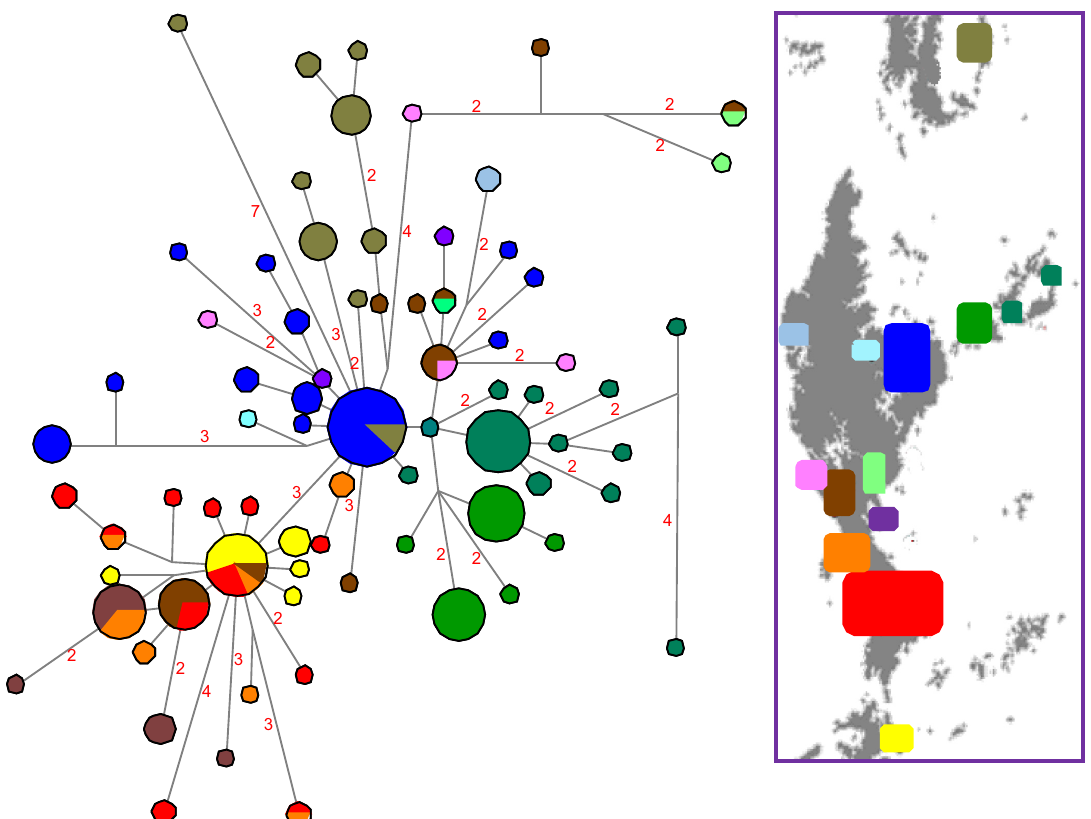
Fig 3. Median joining haplotype network of B . saxicola Southern clade. Legends for the colors of locations are indicated in the map. The number of substitutions is proportional to the length of the line connecting haplotypes and is also shown, except when there is only one mutational step. The size of the circle is proportional to the frequency of the haplotype obtained in the sample.